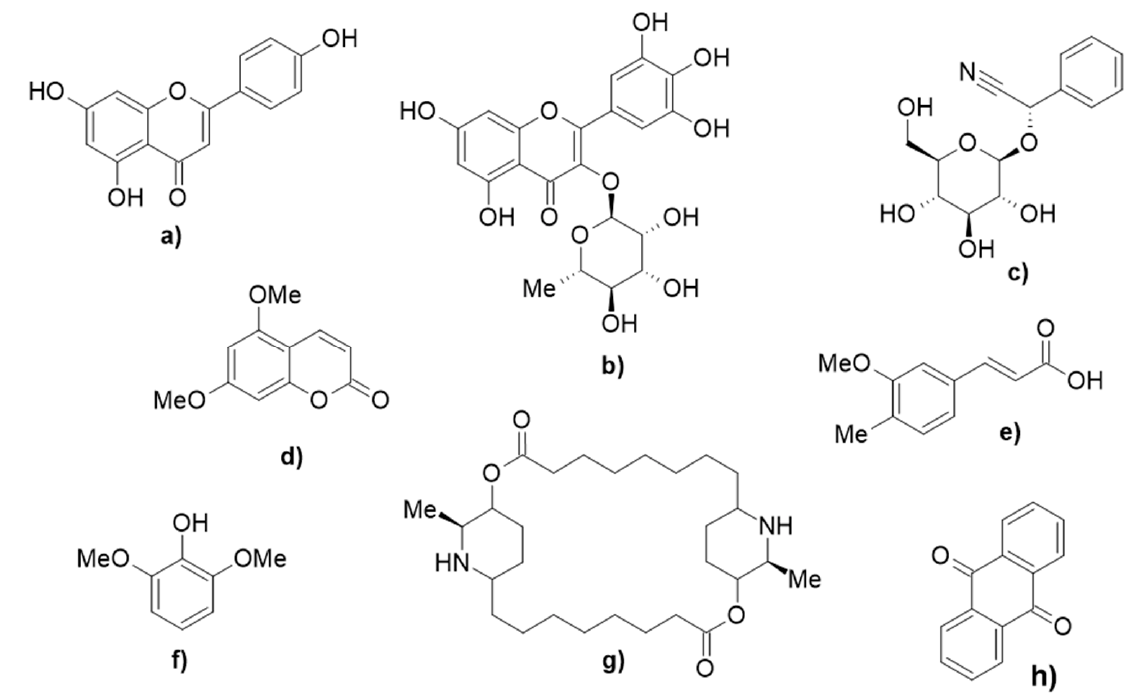
Figure 1. The representative compounds deposited in papaya leaf from each class: ( a ) apigenin, ( b ) myricetin 3-rhanmnoside, ( c ) 2 S -sambunigrin, ( d ) 5,7-dimethoxycoumarin, ( e ) ferulic acid, ( f ) 2,6-dimethoxyphenol, ( g ) carpaine, and ( h ) anthraquinone [79–88].